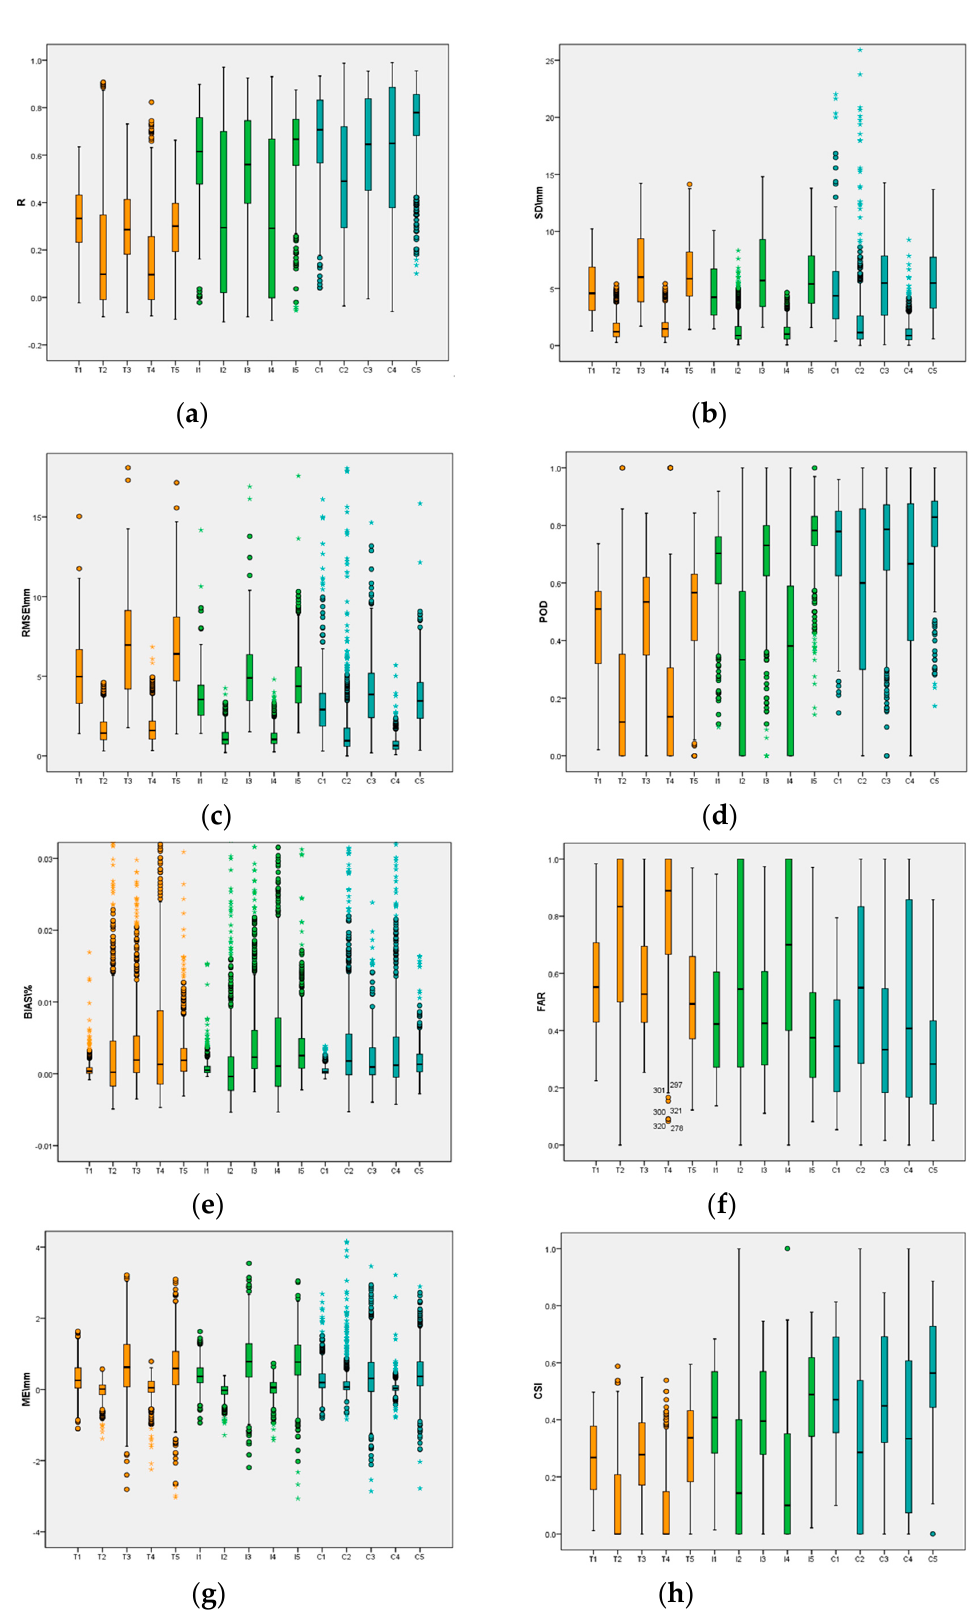
Figure 4. Box plots of assessment markers: T1–T5, I1–I5 and C1–C5 show T (TMPA), I (IMERG) and C (CMADS) in the full 2014–2016 cycle, first dry season, first rainy season, second dry season and second dry season.